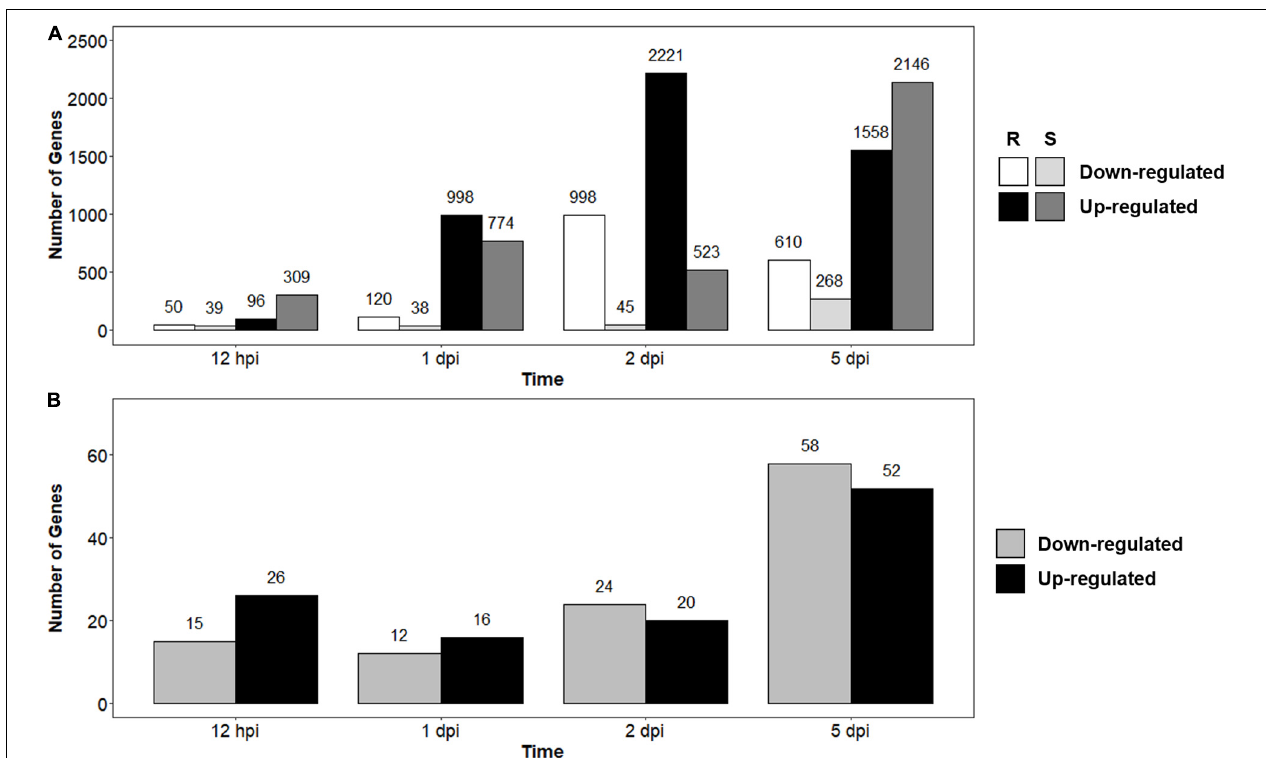
FIGURE 2 | Number of differentially expressed genes (DEGs) identified through RNA-seq analysis over the time series in (A) Resistant (R-interaction) and susceptible (S-interaction) and (B) Susceptible, control compared to resistant, control (S-C vs. R-C) where gray bars represent genes greater expressed in the S-interaction and black bars represent genes greater expressed in the R-interaction. Genes considered down-regulated with a log 2 (fold change) < –1.00 and up-regulated with log 2 fold change >